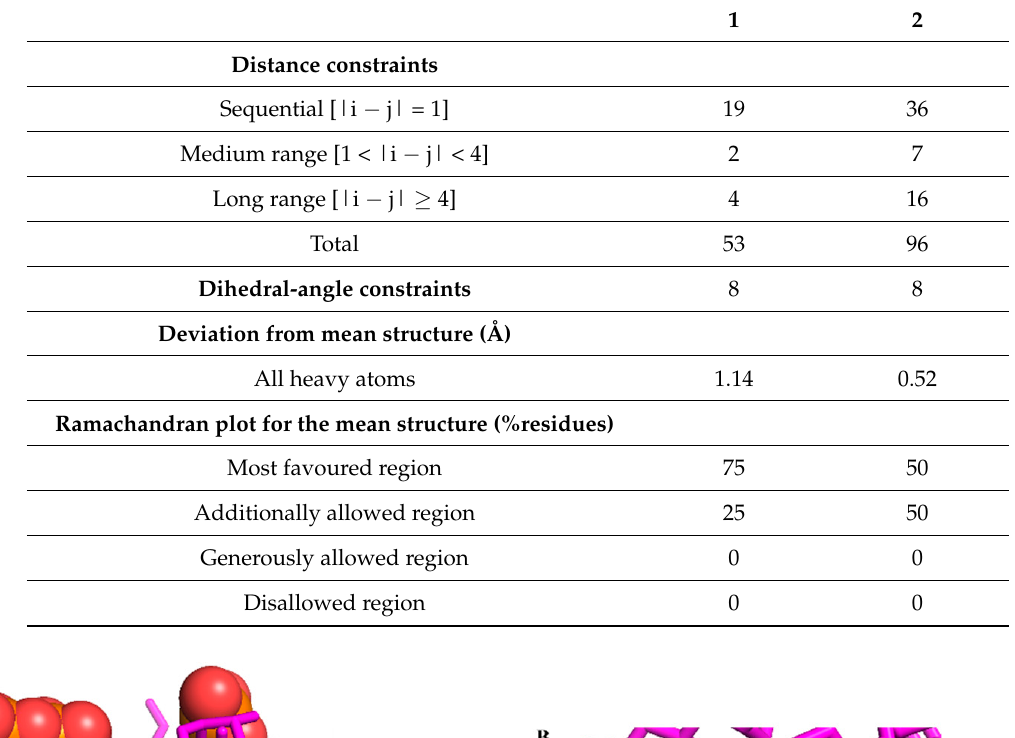
Table 1. Summary of structural statistics: 1, cWY6 in free solution; 2, cWY6 in presence of LPS.